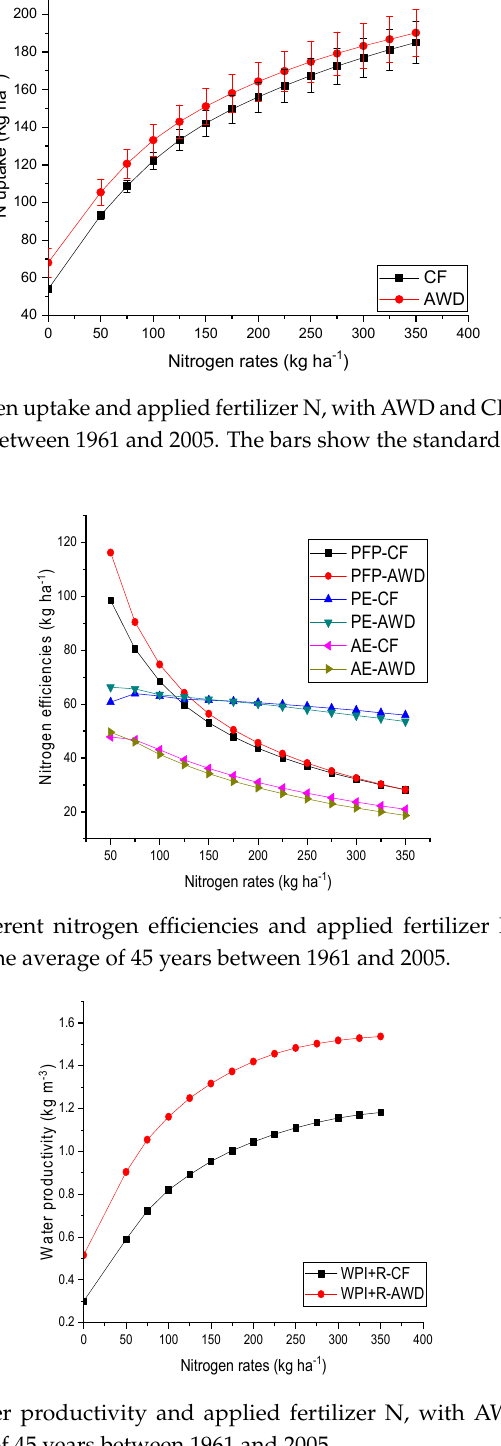
Figure 9. Simulated water productivity and applied fertilizer N, with AWD and CF conditions. Each value is the average of 45 years between 1961 and 2005.